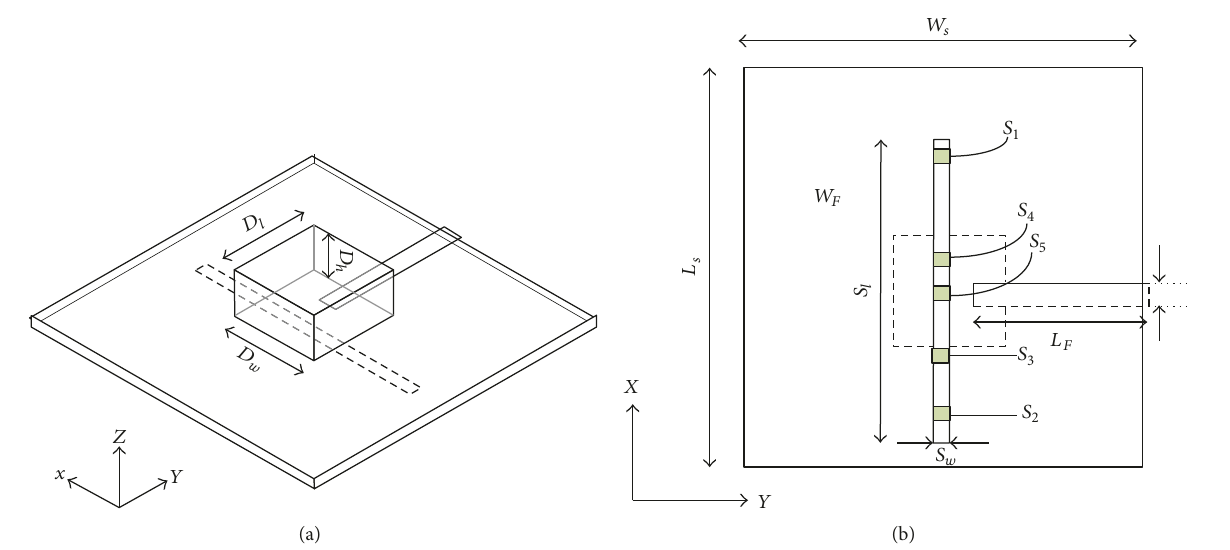
Figure 1: Schematic diagram of the proposed antenna. (a) Front view and (b) back